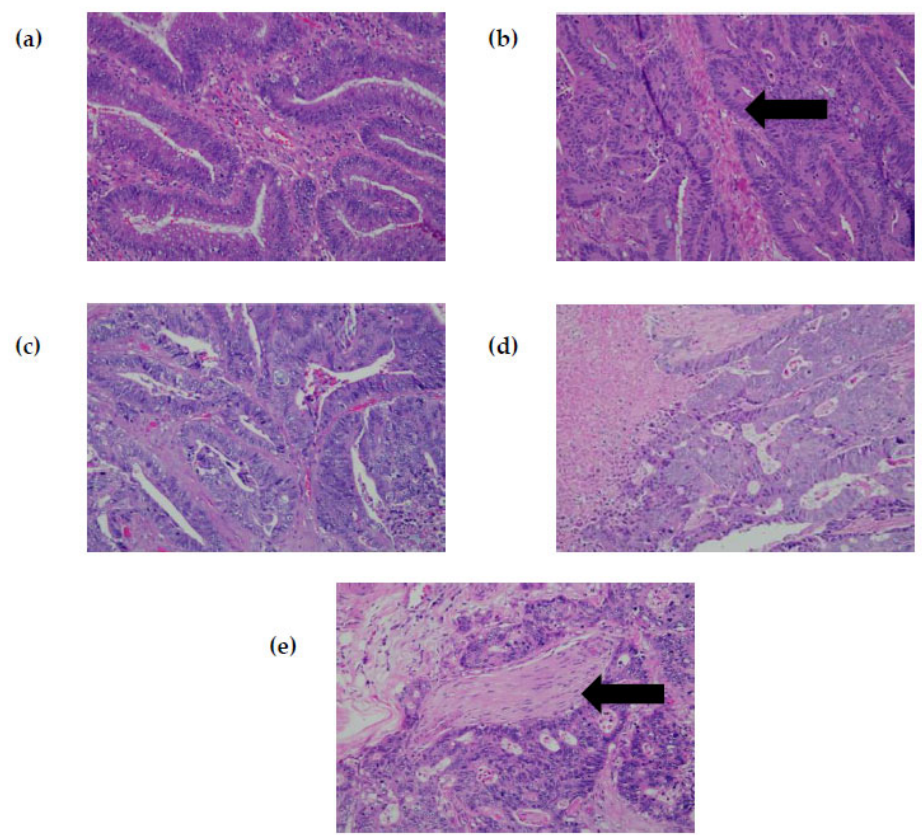
Figure 2. Histological examinations (H&E stain, 200 × ) in selected cases. ( a ) Well-differentiated adenocarcinoma in Case 1 (G12D mutation), showing tumor cells arranged in an irregular glandular pattern infiltrating the stroma; ( b ) well-differentiated adenocarcinoma in Case 2 (G12S mutation), exhibiting malignant glands arranged mainly in a complex glandular pattern which infiltrates into the muscularis propria (black arrow); ( c ) moderately differentiated adenocarcinoma in Case 11 (G13D mutation). Surrounding stroma shows a marked desmoplastic reaction; ( d ) moderately differentiated adenocarcinoma in Case 15 (wild-type KRAS ) with area of necrosis; ( e ) moderately differentiated adenocarcinoma in Case 19 (wild-type KRAS ) exhibiting a cribiform pattern with perineural invasion (black arrow).